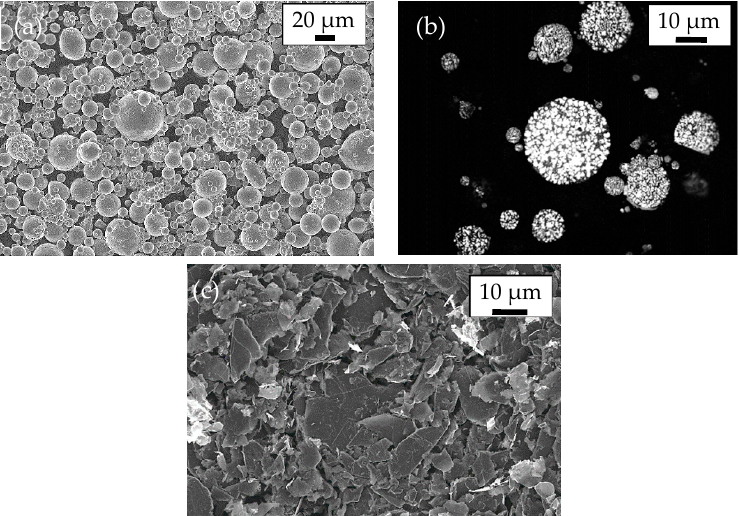
Figure 1. ( a ) Scanning electron microscope (SEM) micrograph of as-received AlSi10Mg power, ( b ) Light Optical Microscopy (LOM) image of the cross-section of AlSi10Mg powder, ( c ) SEM micrograph of graphene